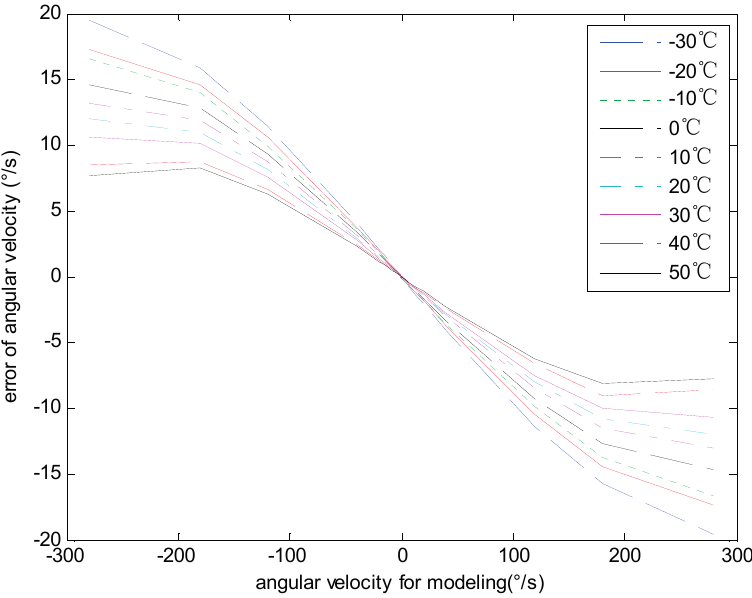
Figure 8. The angular velocity error of modeling data.